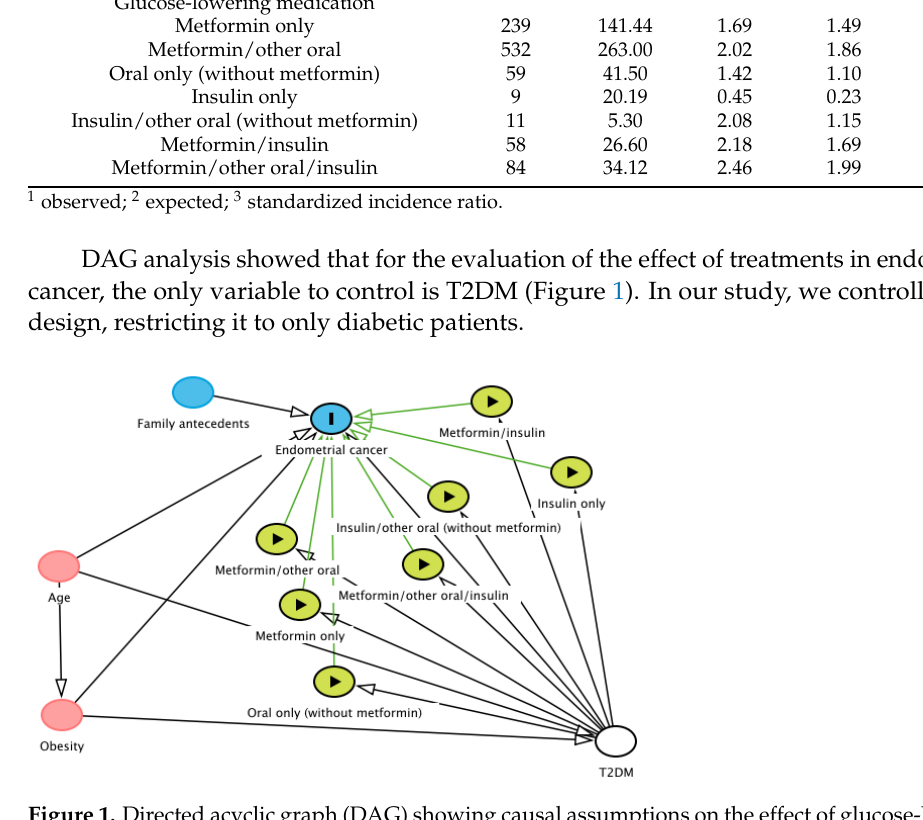
Figure 1. Directed acyclic graph (DAG) showing causal assumptions on the effect of glucose-lower-ing medications (exposure) on endometrial cancer (outcome)*. * Adjusted variable (white color), ancestors of exposure and outcome (red color), exposures (green color), ancestor of outcome (blue color). Based on DAGitty version 3.0 (Johannes Textor, Nijmegen, the Netherlands).